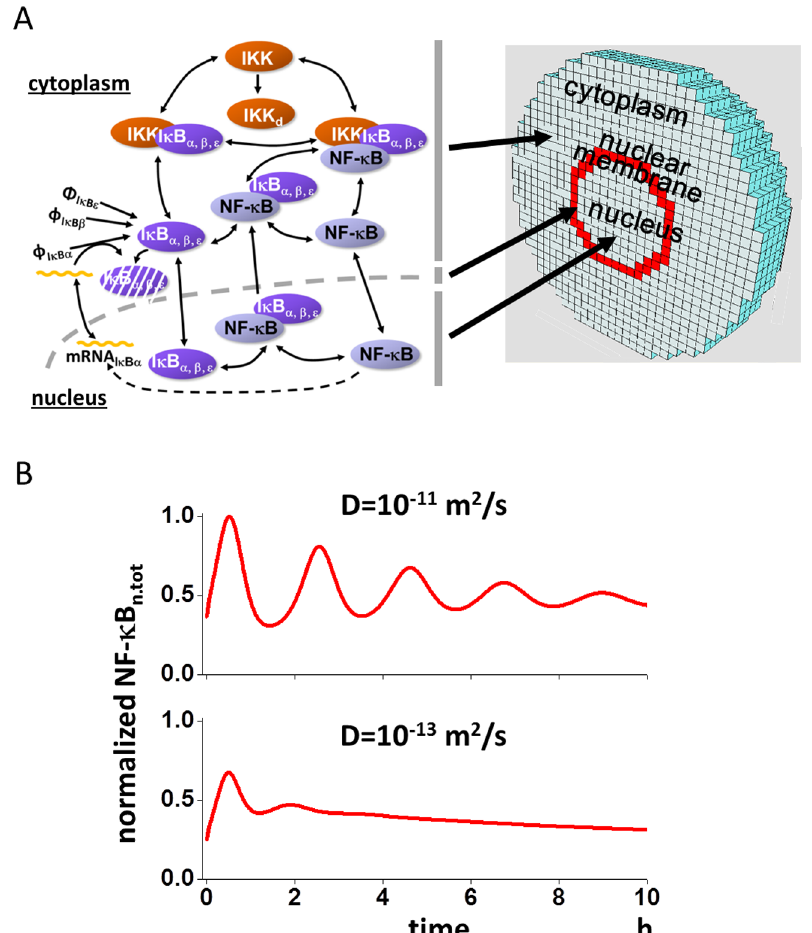
Figure 1. Oscillation pattern of nuclear NF- k B is altered by the change in diffusion coefficient. (A) Reaction schemes and the shape of the 3D model were the same as in a previous report [39], and the detailed reaction scheme and parameter values are shown in Figure S1 and Table S1. The 3D model had a spherical shape with a diameter of 50 m m, which was divided into 62,417 cubic compartments allowing reaction-diffusion simulations. Reaction schemes were embedded into the corresponding region of the cytoplasm, nuclear membrane (red compartments) and nucleus. (B) The effect of the diffusion coefficient on the oscillation pattern of NF- k B n.tot . NF- k B n.tot was the summation of the concentrations of free NF- k B n and I k B n :NF- k B n in the nucleus, which corresponded to the fluorescent light intensity in the experiments. While NF- k B n.tot oscillated at D for proteins of 10 2 11 m 2 /s, it did not oscillate at a smaller D for proteins of 10 2 13 m 2 /s.